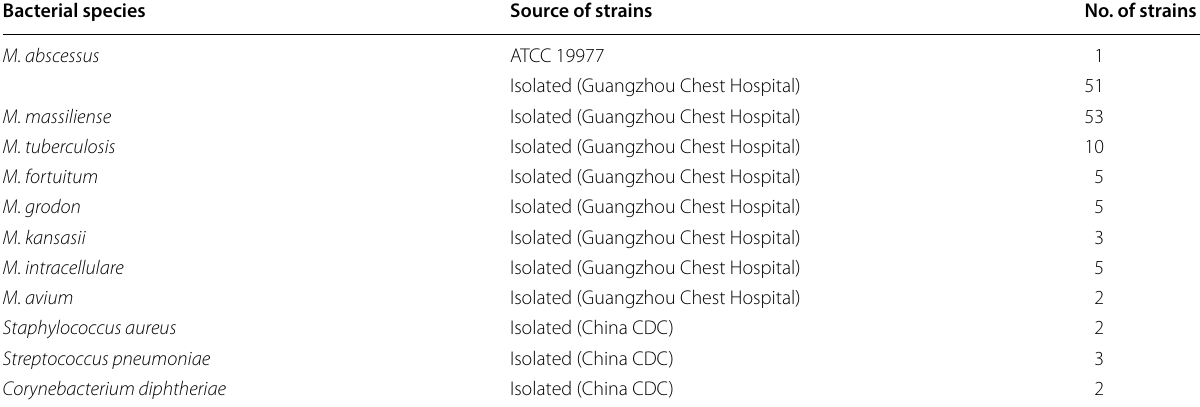
Table 1 Strains used in this study Bacterial species Source of strains